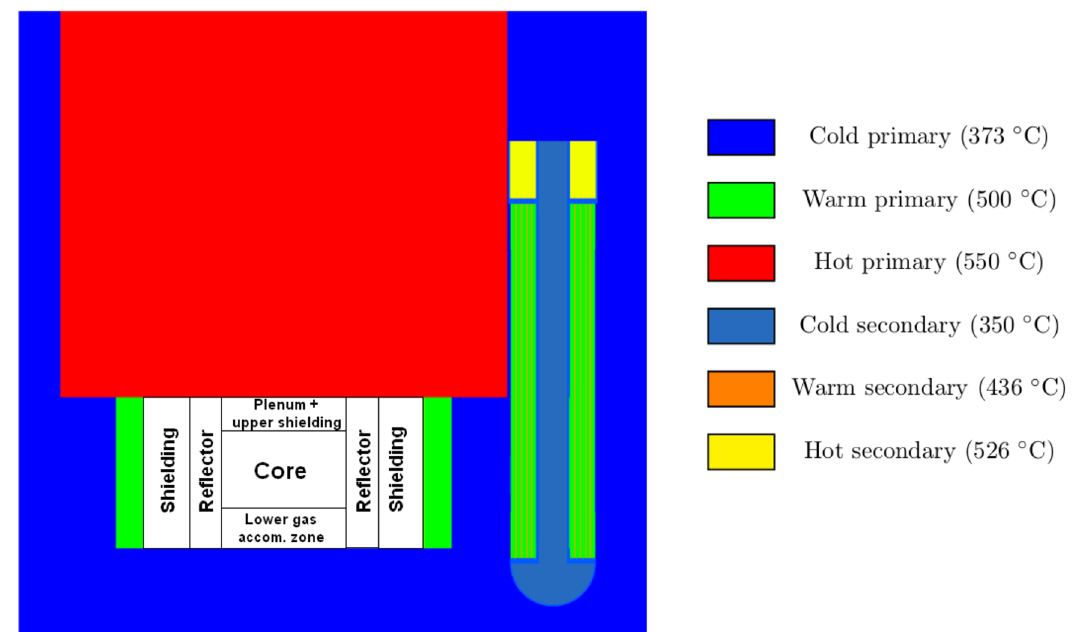
Fig. 25. Position of the IHX and the temperatures used for sodium (TRIPOLI-4 ®